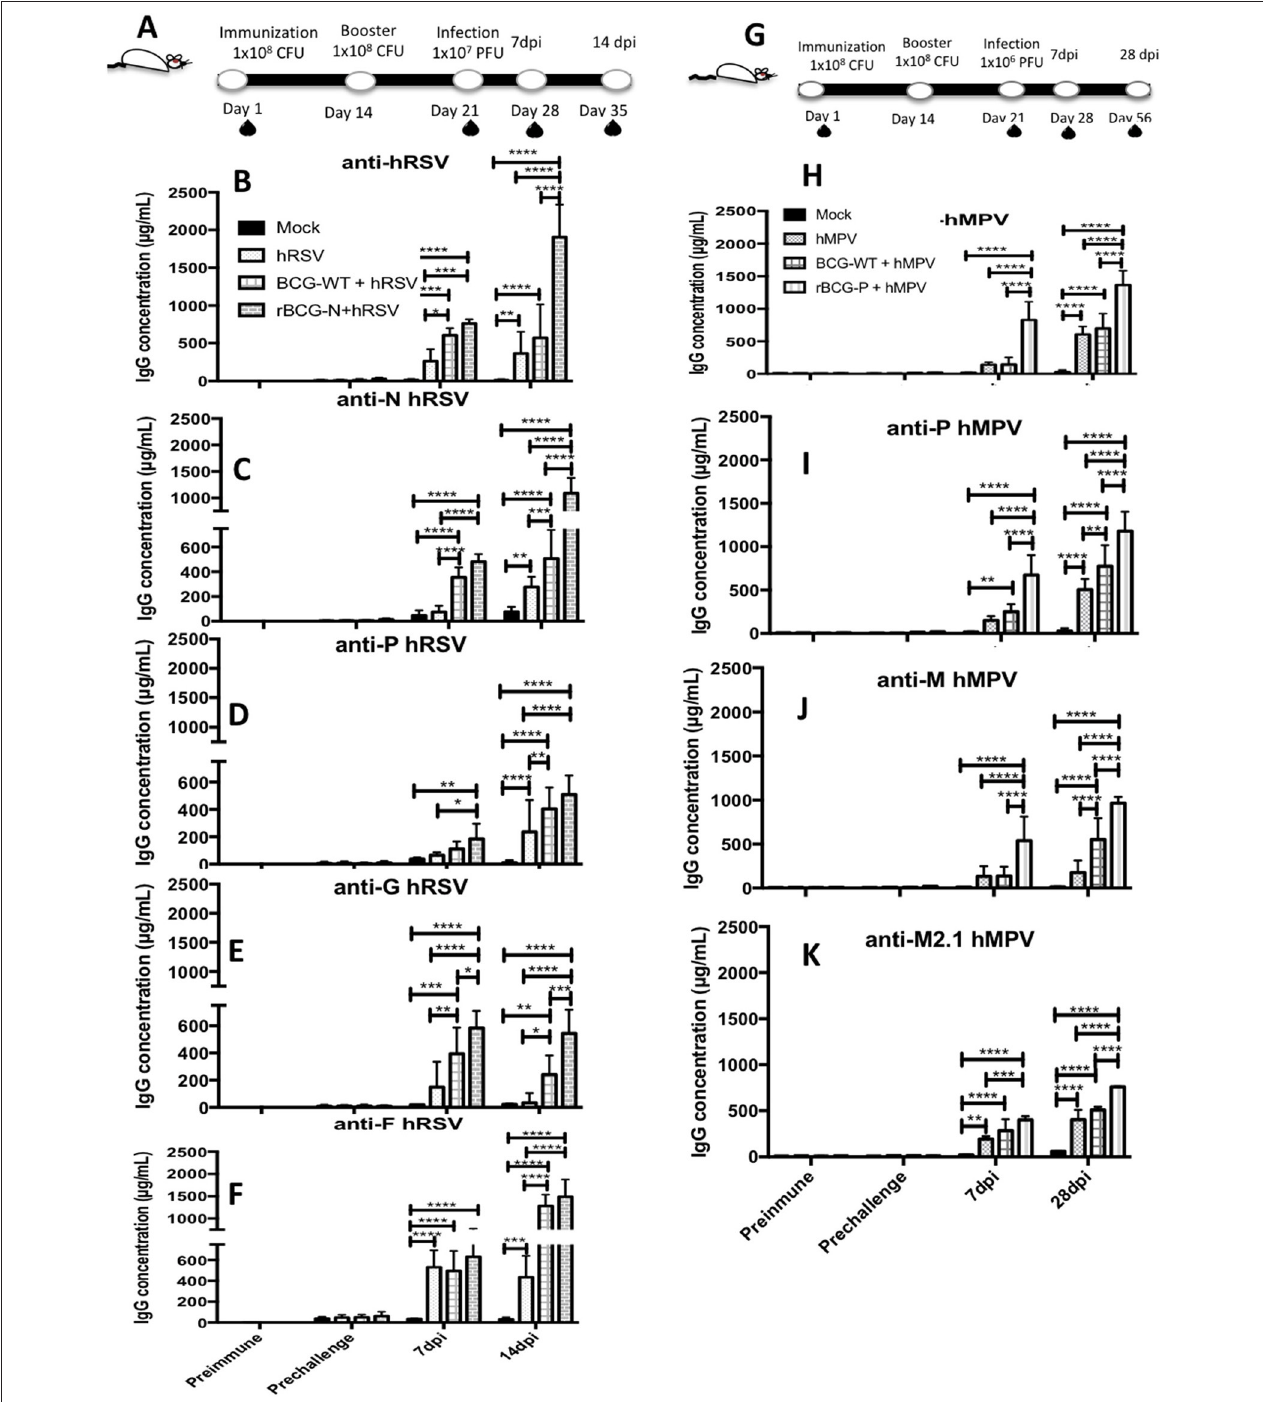
FIGURE 2 | Evaluation of the induction of IgG specific-antibodies against viral antigens after a viral infection. IgG for different antigens were evaluated from the sera obtained at different time points: Prior to immunization (Preimmune), prior to virus infection (Prechallenge), 7 and 14 days post-infection (7 dpi and 14 dpi) for hRSV or 7 dpi and 28 dpi for hMPV, respectively (A, G) . Specific antibodies levels were determined by ELISA assay against hRSV (B) , N protein (C) , P protein (D) , G protein (E) , F protein (F) . Similarly, this same ELISA assays were done against hMPV (H) , P protein (I) , M2.1 protein (J), and M protein (K) . The bars observed in the (B–F) are accordingly: Mock-treated, hRSV-infected, BCG-WT + hRSV, and rBCG-N + hRSV. On the other hand, the bars observed in (H–K) are accordingly: Mock-treated, hMPV-infected, BCG-WT + hMPV, and rBCG-P + hMPV. The measure was made at 450nm. The sera from 6 different animals for each group was used for the ELISA assay, with each serum tested in 3 replicates. N = 3 for each group, with two independent experiments. Differences were evaluated by a two-way ANOVA (* p < 0.05; ** p < 0.01; *** p ≤ 0.001; **** p ≤ 0.0001). The error bars represent the Standard Deviation